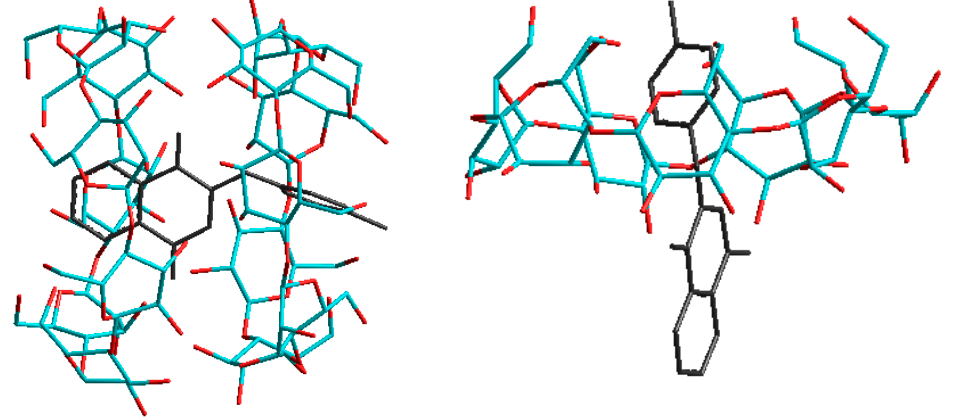
Figure 4. Molecular modeling predicted energy structures for the 2:1 ( left ) and 1:1 anilino ( right ) host:guest complexes formed between β -CD and 2-[( p -methyl-phenyl)amine]-1,4-naphthalenedione (PAN derivative 1) and observed in the ESI-MS spectrum shown in Figure 2.